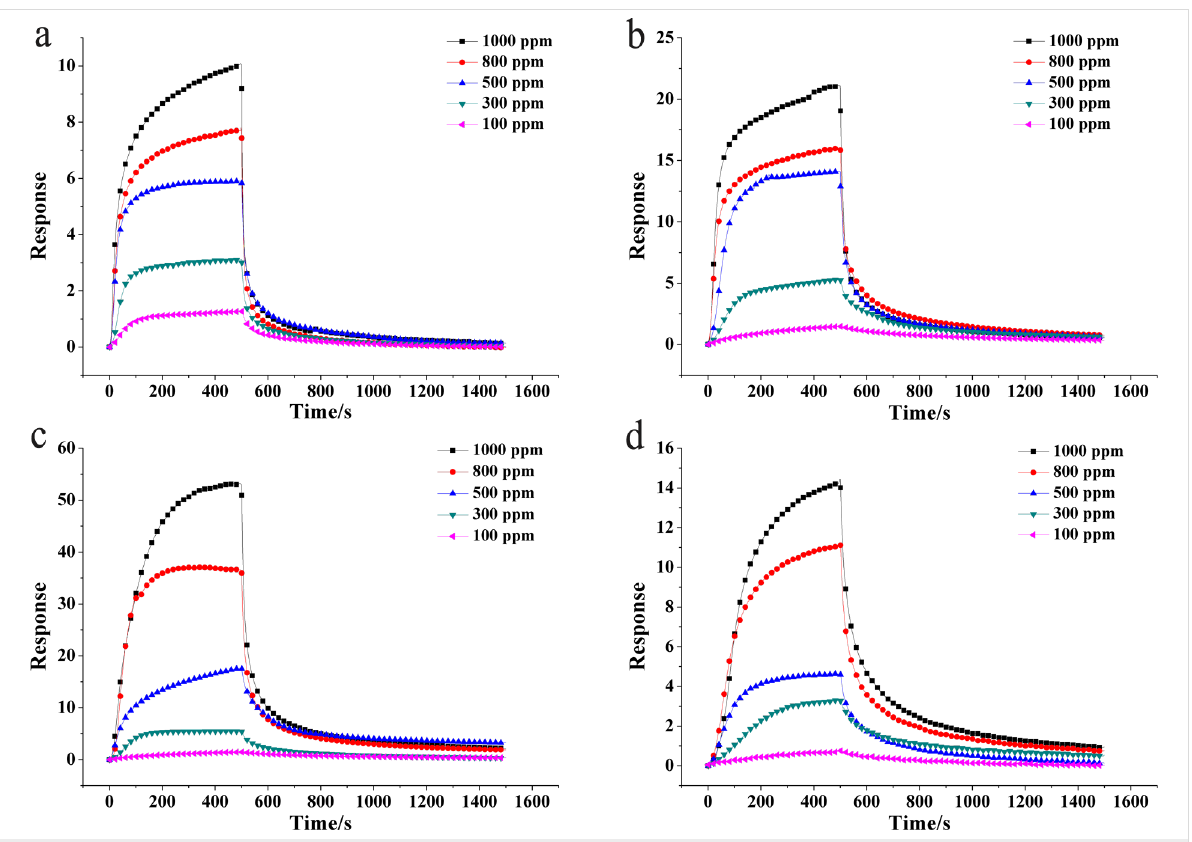
Figure 5: Dynamic response of sensors based on (a) pure PANI, (b) In 2 O 3 /PANI nanofibers-1, (c) In 2 O 3 /PANI nanofibers-2 and (d) In 2 O 3 /PANI nano- fibers-3 towards 100–1000 ppm NH 3 at room temperature.